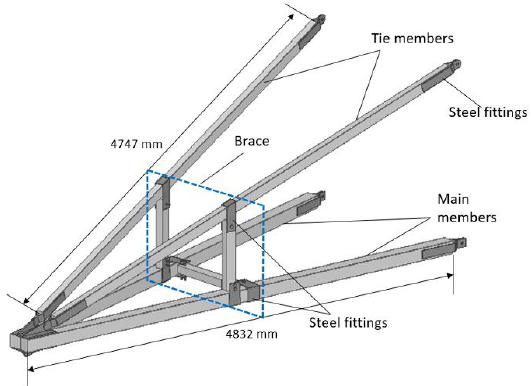
Figure 3. The FRP composite crossarm with an installed brace for the 275 kV transmission line.